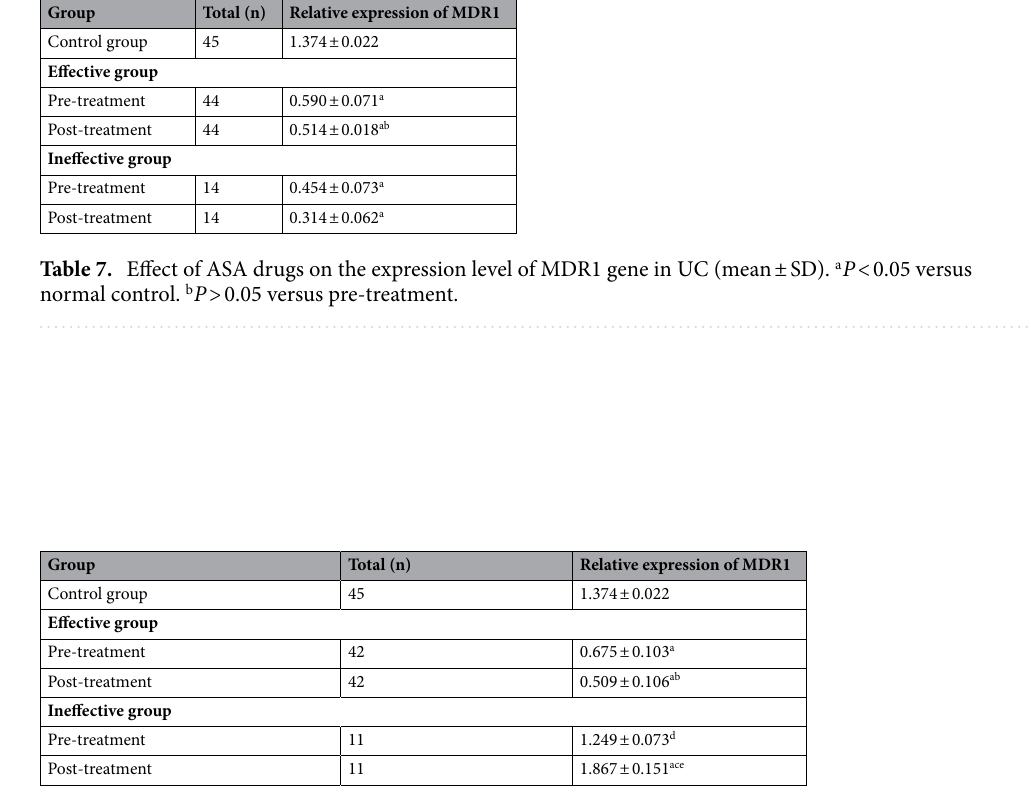
Table 8. Effect of glucocorticoid on the expression level of MDR1 gene in UC (mean ± SD). a P < 0.05 versus control group. b P > 0.05 versus pre-treatment. c P < 0.05 versus pre-treatment. d P < 0.05 versus effective group pre-treatment. e P < 0.05 versus effective group